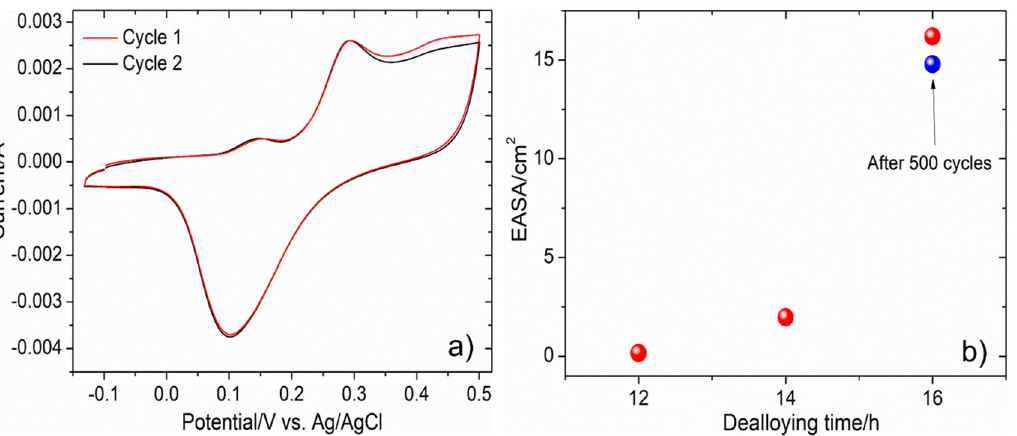
Figure 5. ( a ) CV scans of NPG_16h in the potential range of -0.13 to 0.5 vs. Ag/AgCl in 0.5 M KOH solution. ( b ) EASA of NPG_12h, NPG_14h, and NPG_16h denoted by red dots before methanol electro-oxidation and EASA of NPG_16h denoted by a blue dot after 500 CV scan cycles of methanol